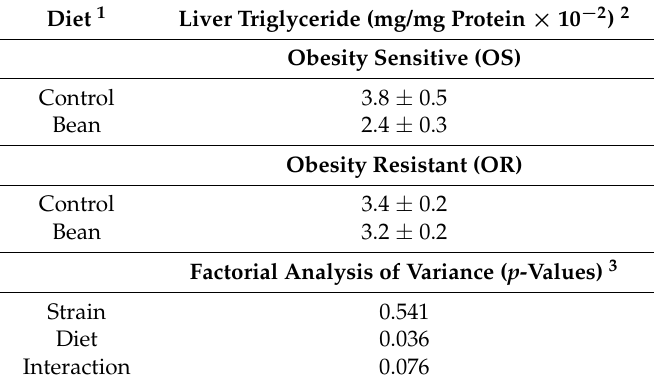
Figure 2. Effects on lipid metabolism ( A ) Serum triglycerides; different than respective control, p < 0.05); ( B ) Regression of sum visceral fat vs. serum triglyceride; ( C ) Regression of serum triglyceride vs. liver CPT1 expression; ( D ) Regression of sum visceral fat to liver CPT1 expression. LCL: lower confidence limit; UCL: upper confidence limit; LPL: lower prediction limit; UPL: upper prediction limit. Table 5. Effect of paired feeding of commercially processed bean powder on liver triglyceride.